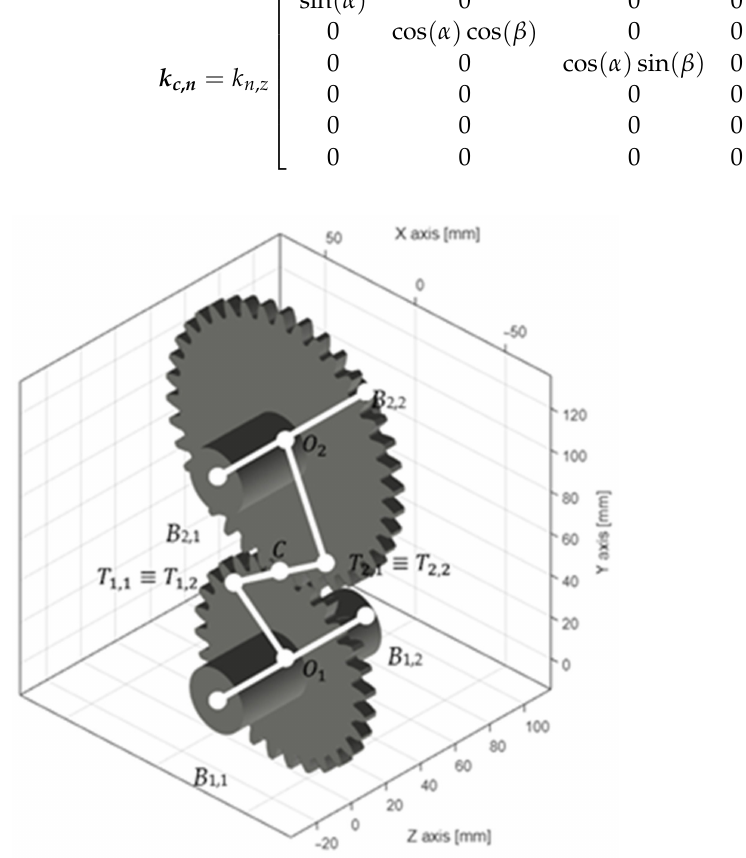
Figure 2. Scheme of the kinematic arrangement. FE elements schematized in